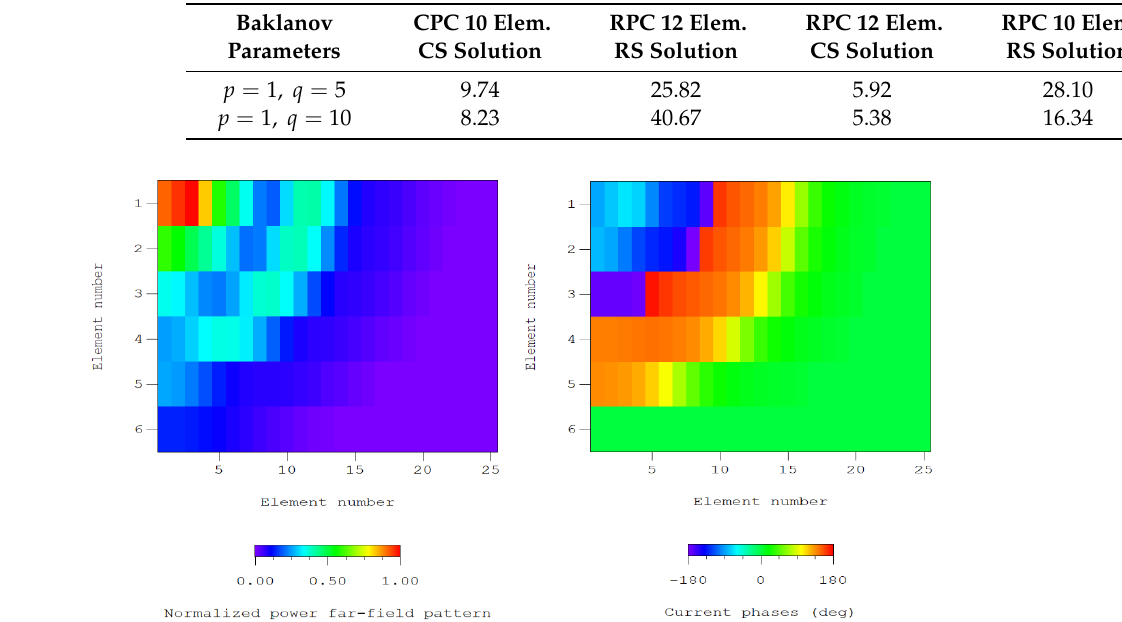
Figure 14. Detailed view of the layout after deleting the less excited elements |𝐼 𝑚𝑛 |/|𝐼 𝑚𝑎𝑥 | < 10 −2 , case of the generalized Tseng–Cheng method with 𝑝 = 1 and 𝑞 = 10: normalized amplitudes of the excitation currents ( left ) and current phases in degrees ( right ).